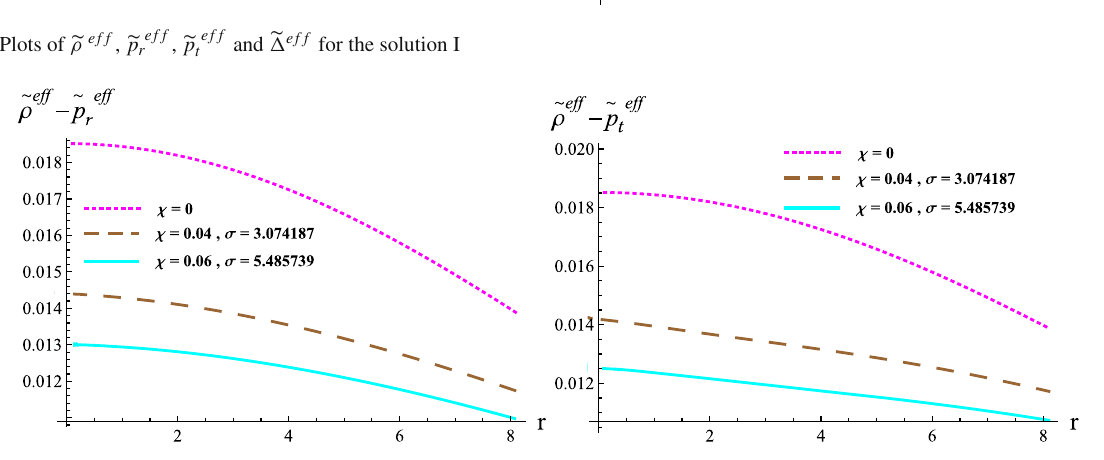
Fig. 1 Plots of (cid:5) ρ ef f , (cid:5) p ef f r , (cid:5) p ef f t and (cid:5) (cid:14) ef f for the solution I